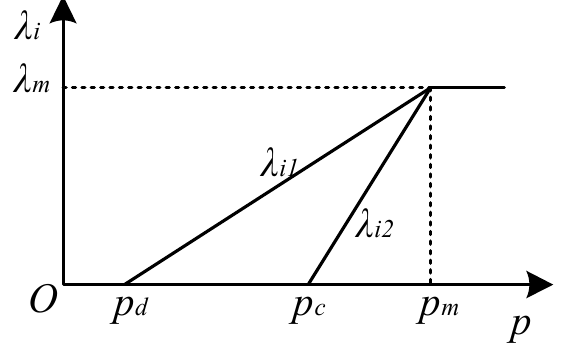
Figure 2. User response characteristic curve under certain incentive level.